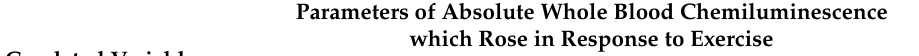
Table 7. Correlations ( δ ) between parameters of absolute whole blood chemiluminescence which rose in response to exercise with measures of exhaustive treadmill run.